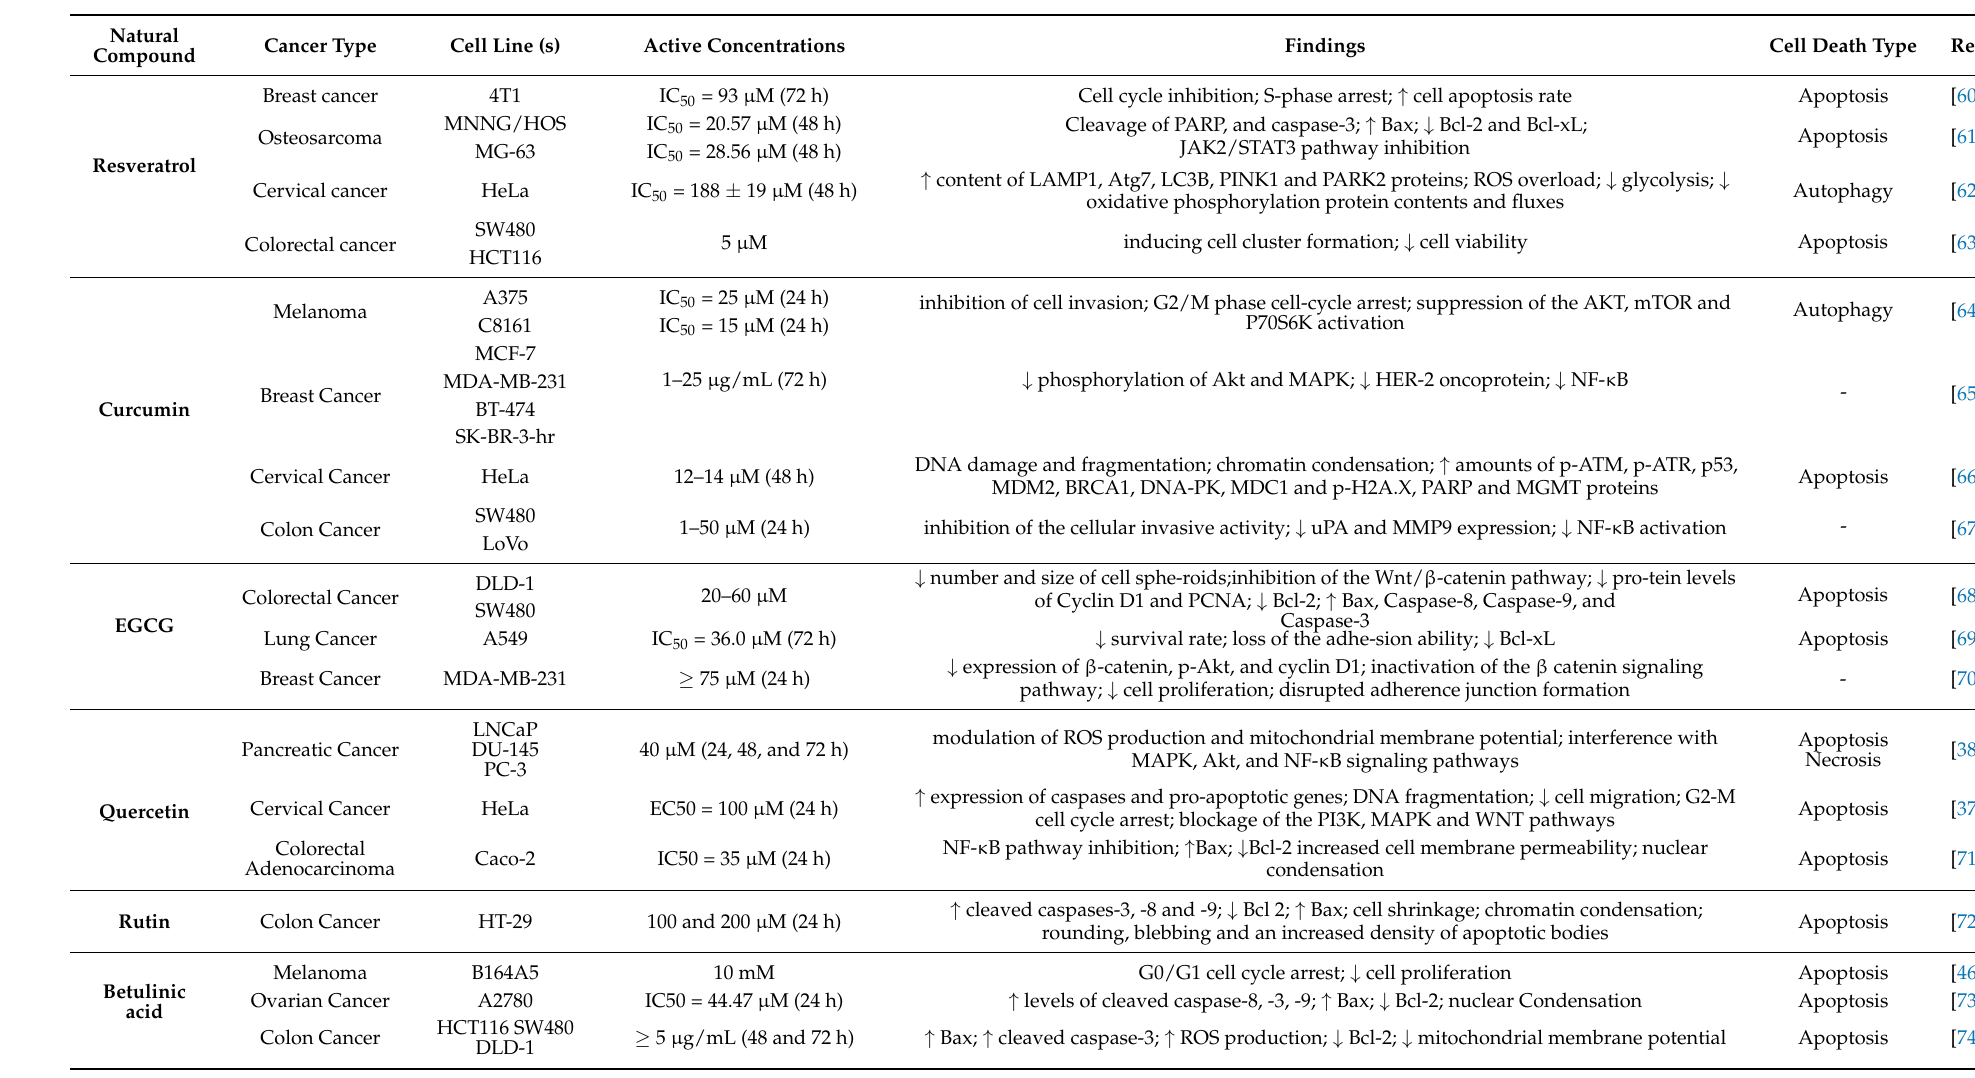
Table 1. Relevant in vitro studies, based on natural compounds with antitumor properties, subsequently correlated with in vivo studies and clinical